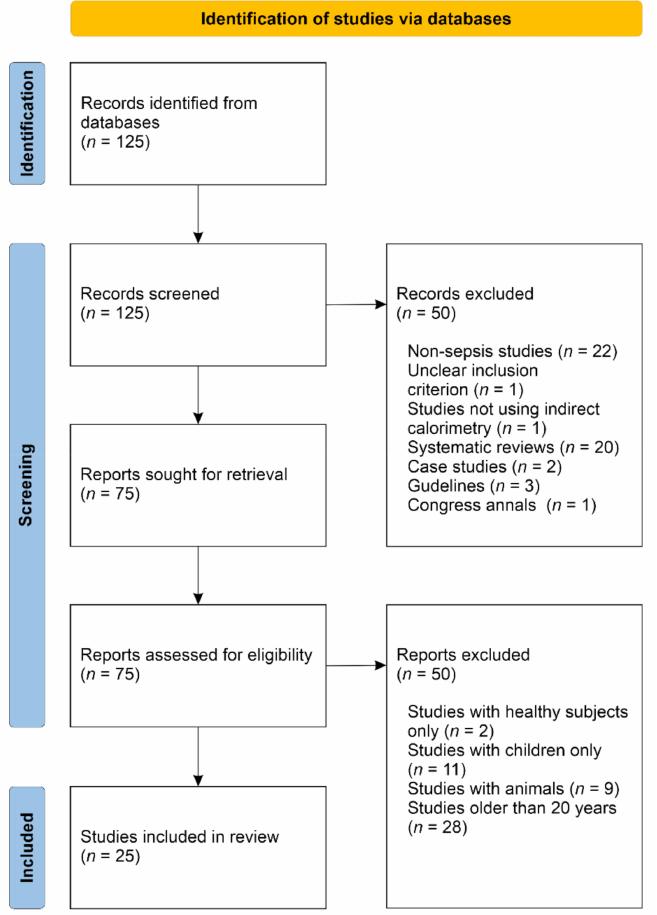
Figure 2. PRISMA flow diagram of the literature search process